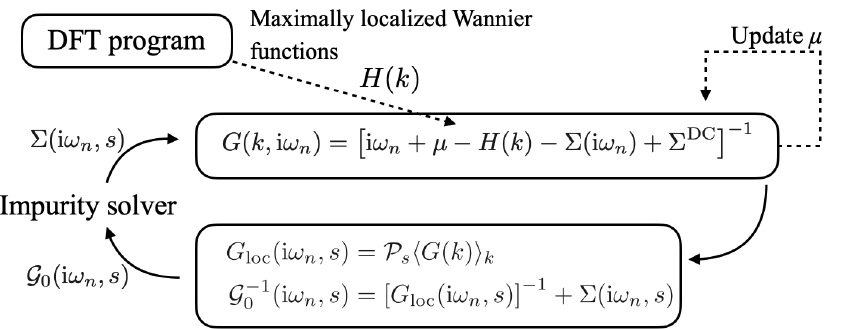
Figure 1: Illustration of the DMFT self-consistency cycle defined in Eqs. (6)–(10). The most numerically expensive step is the solution of the impurity problem, i.e., the calculation of the self-energy for a given momentum space and µ is the chemical